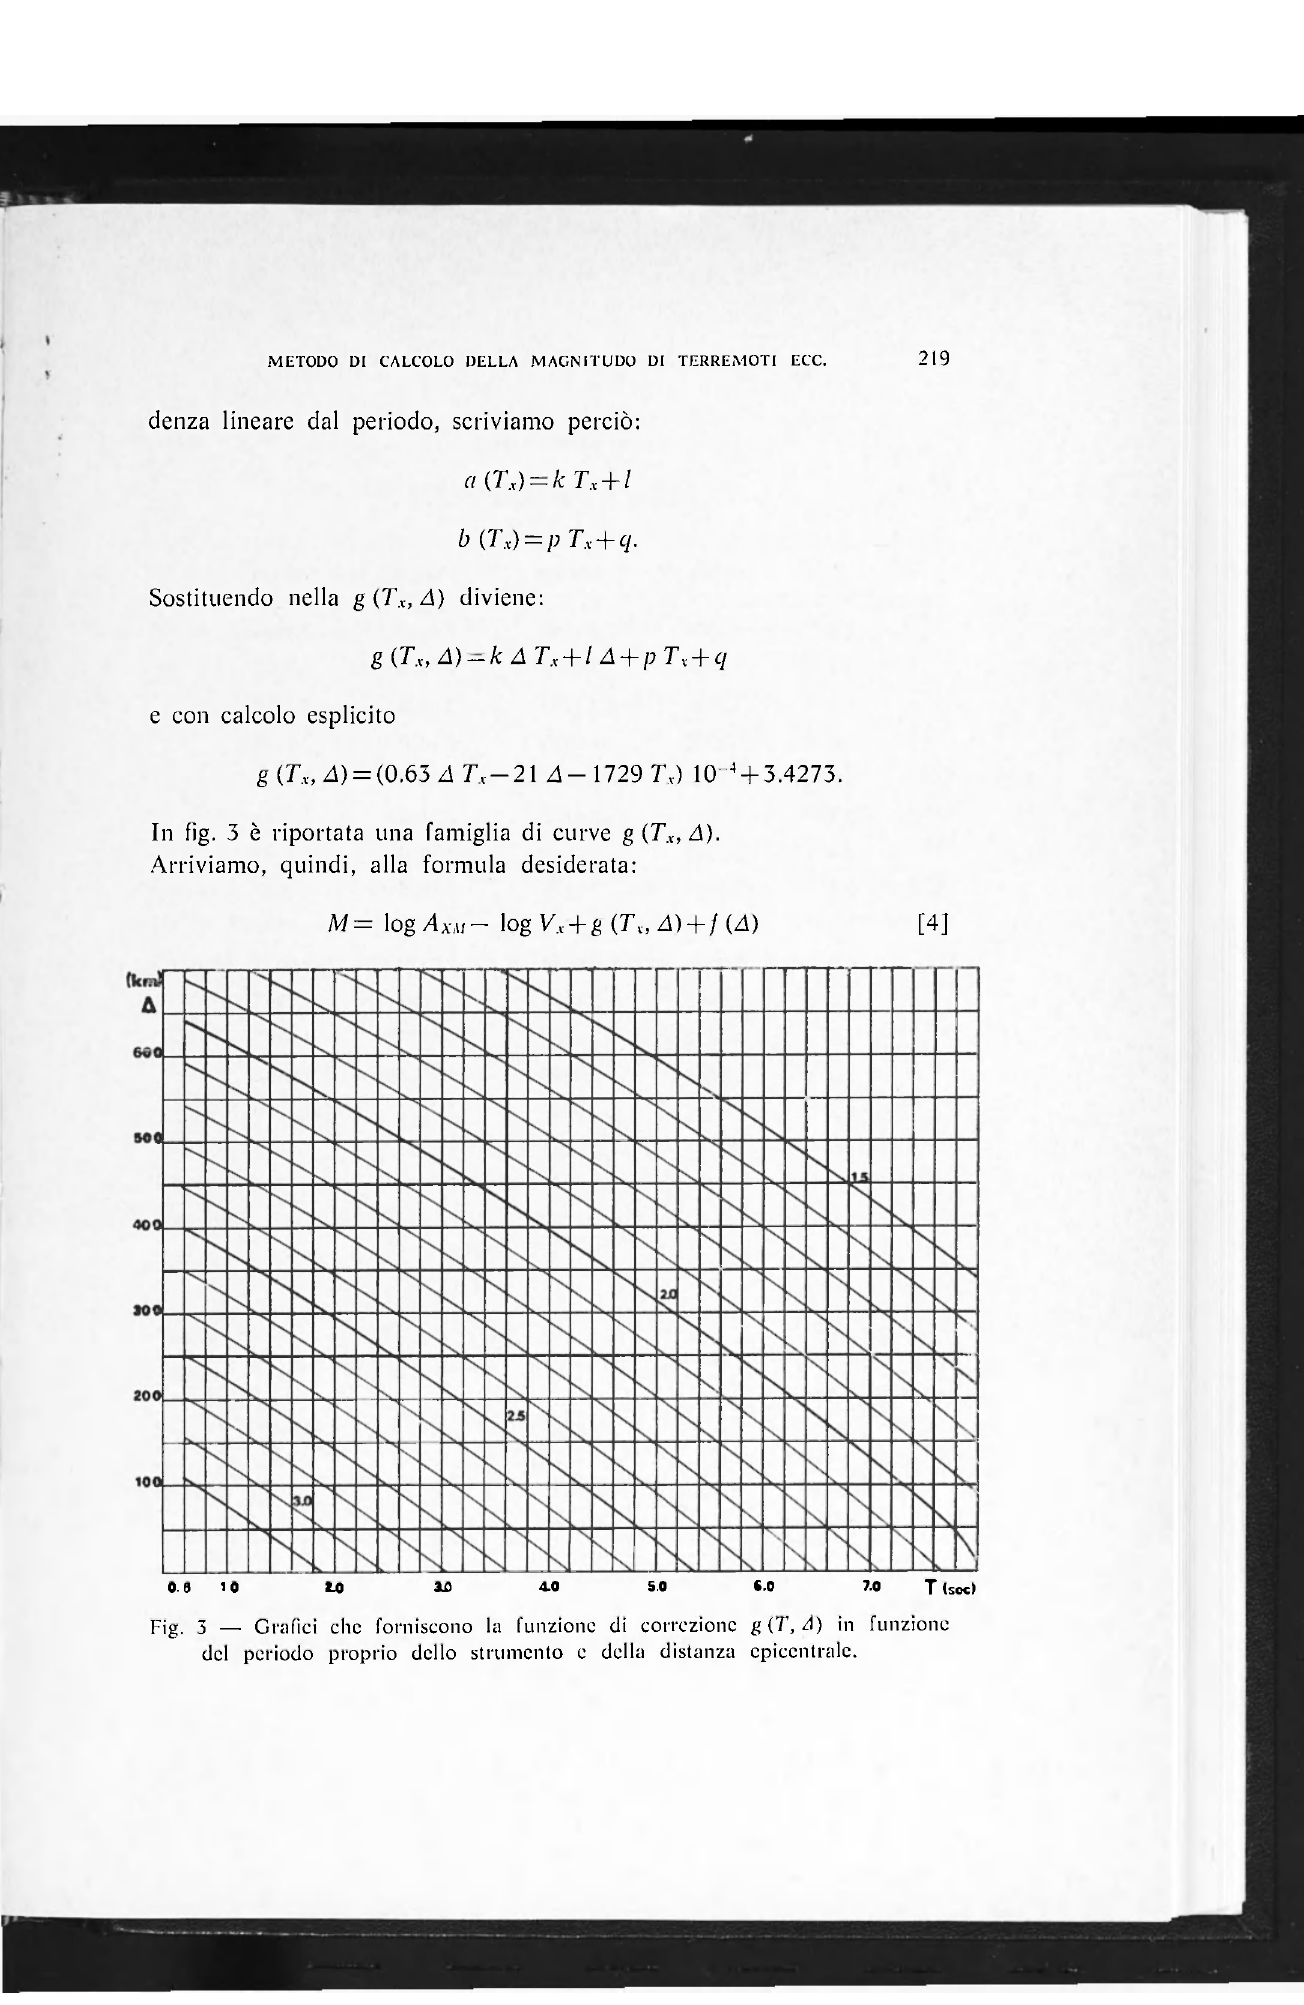
Fig. 3 — Grafici che forniscono la funzione di correzione g(T,A) in funzione del periodo proprio dello strumento e della distanza